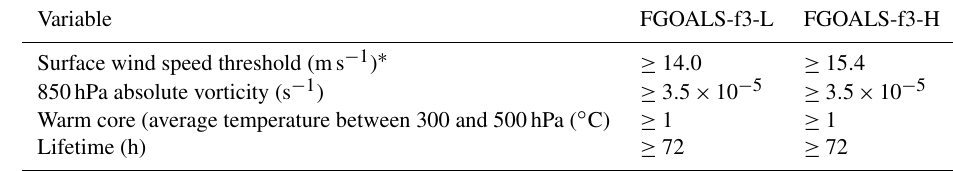
Table 3. Comparison of tropical cyclone identification criterion between FGOALS-f3-L and FGOALS-f3-H.